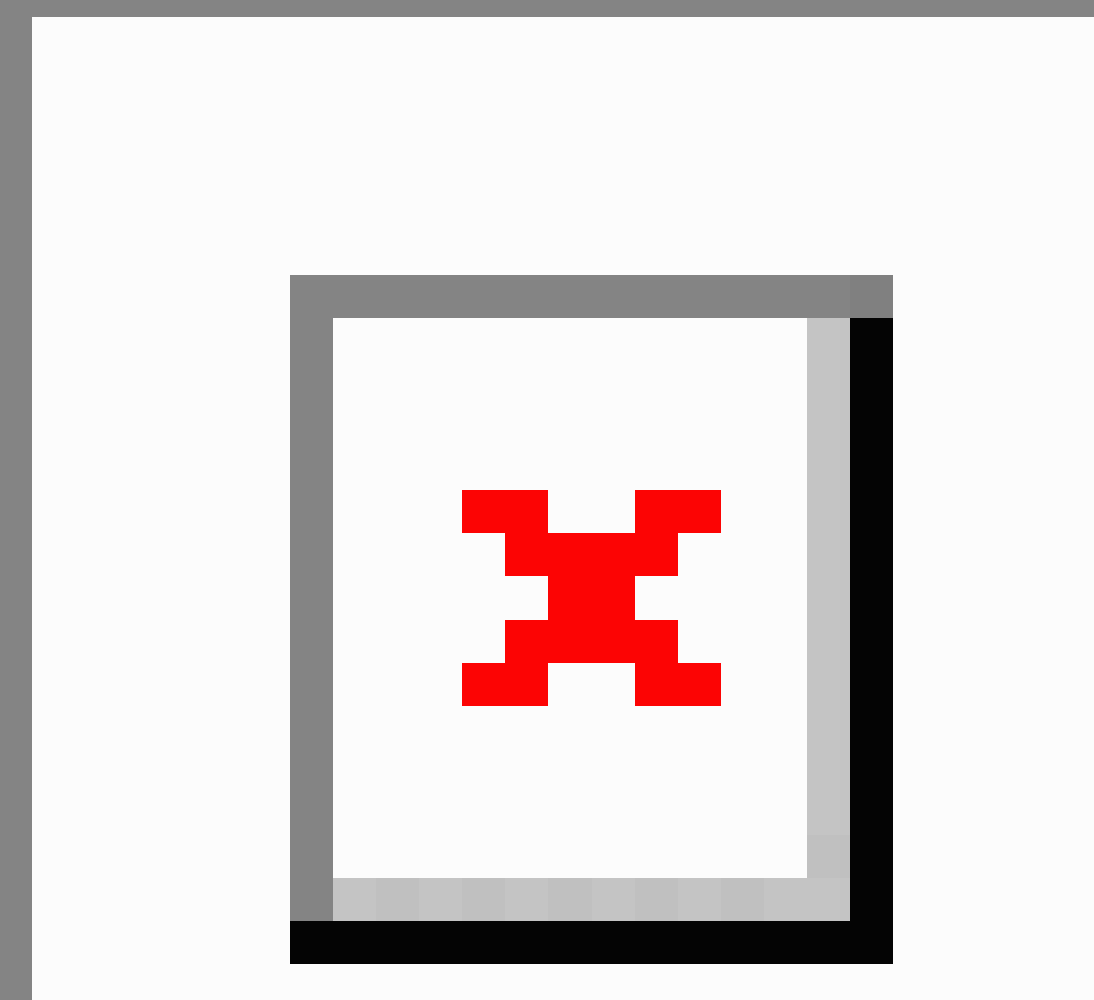
Figure 4. Examples of participants from clusters; High engagement (red), Moderate engagement (purple), Low engagement (green), Tourists (teal).